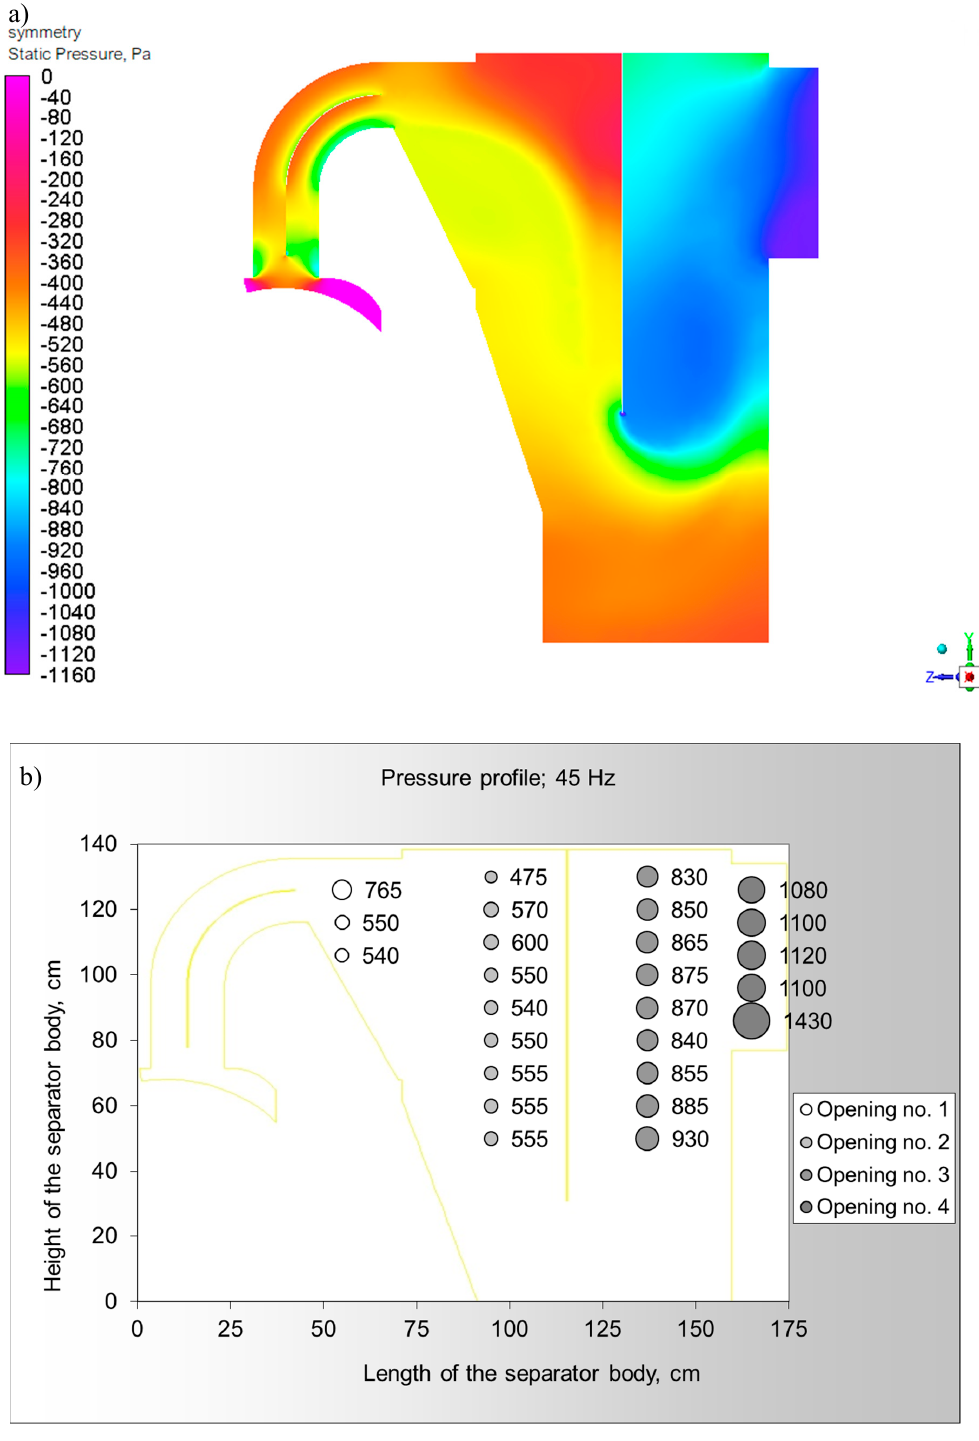
Figure A14. Pressure profile in the sorter symmetry plane (simulation of the main fan at 45 Hz): ( a ) numerical model (gauge pressure) and ( b ) measured (negative pressure).